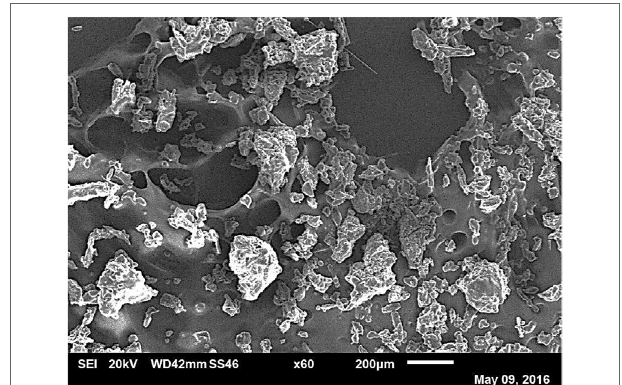
FigUre 6 | SEM of [N 4444 ][Ac] at 50 wt% cellulose loading showing agglomeration of cellulose particles (white) rather than surface coating.